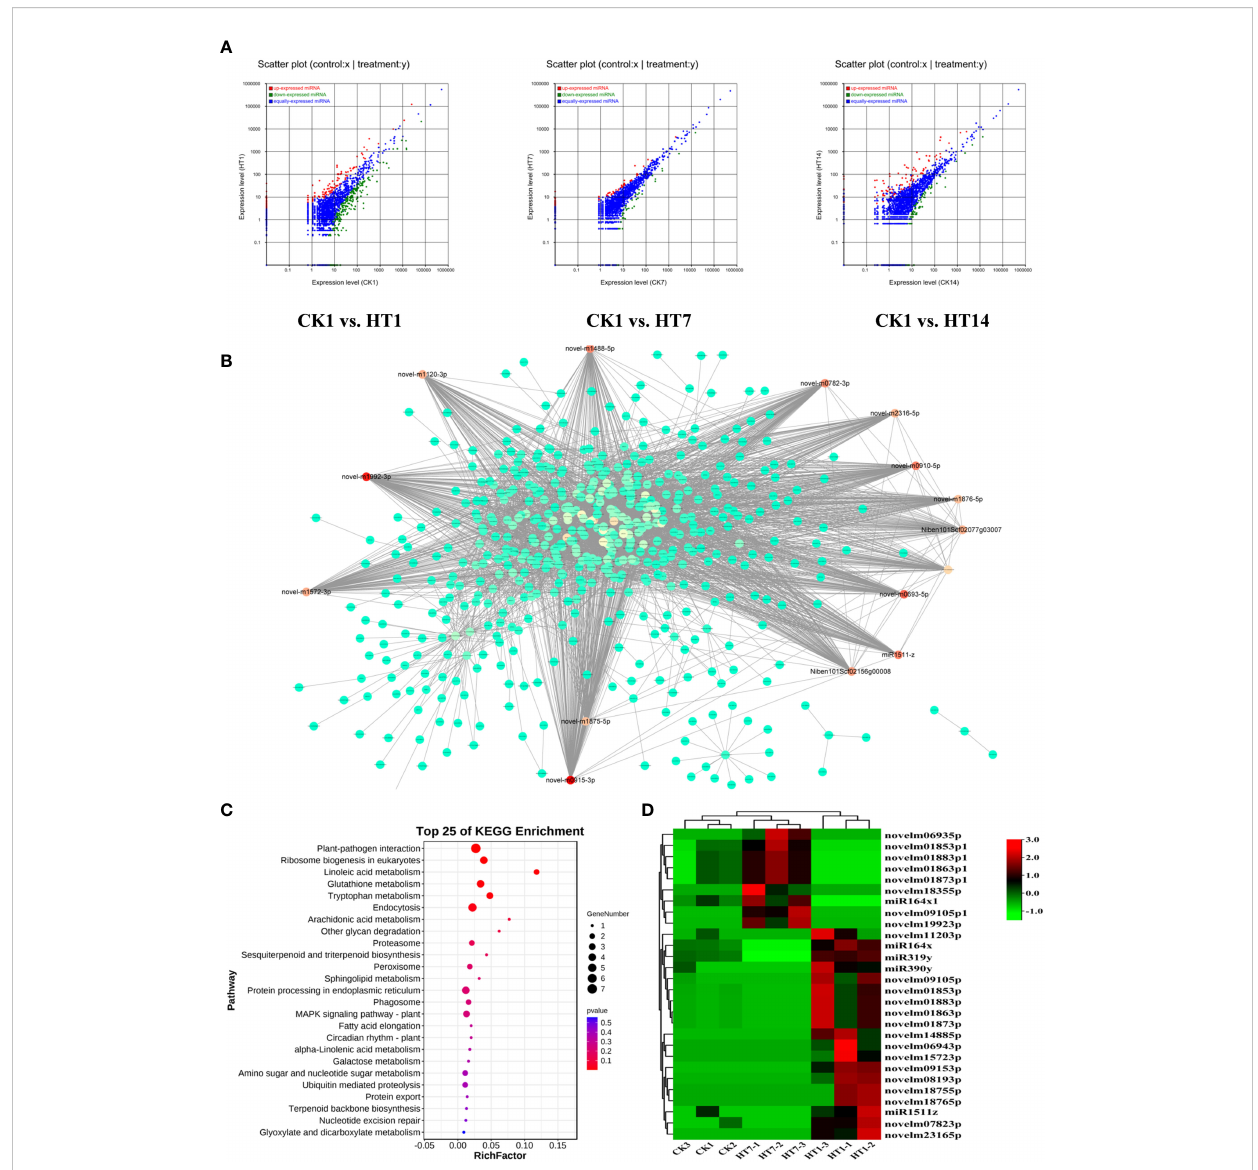
FIGURE 6 TH complex infection deployed various miRNAs of Nicotiana benthamiana to suppress the genes involved in plant resistance. (A) Scatter plots represent the differentially expressed miRNAs in CK vs. TH1, CK vs. TH7, and CK vs. TH14 pairwise comparisons. The up and downregulated miRNAs are shown in red and green, while the blue plots represent the miRNAs without signi fi cant changes. (B) A co-expression network of TH-triggered miRNA and genes relevant to plant resistance. The color represents the importance of each gene or miRNA in the network. The hub TH-triggered miRNAs are shown in red. (C) Top 20 enriched KEGG pathways based on the genes involved in the co-expression network. (D) A heatmap displays the dynamic changes of hub miRNAs in N. benthamiana following TH complex infection at 7 and 14 days. Heatmaps were generated using the mean TPM value of miRNAs in each treatment at different conditions. ** P <